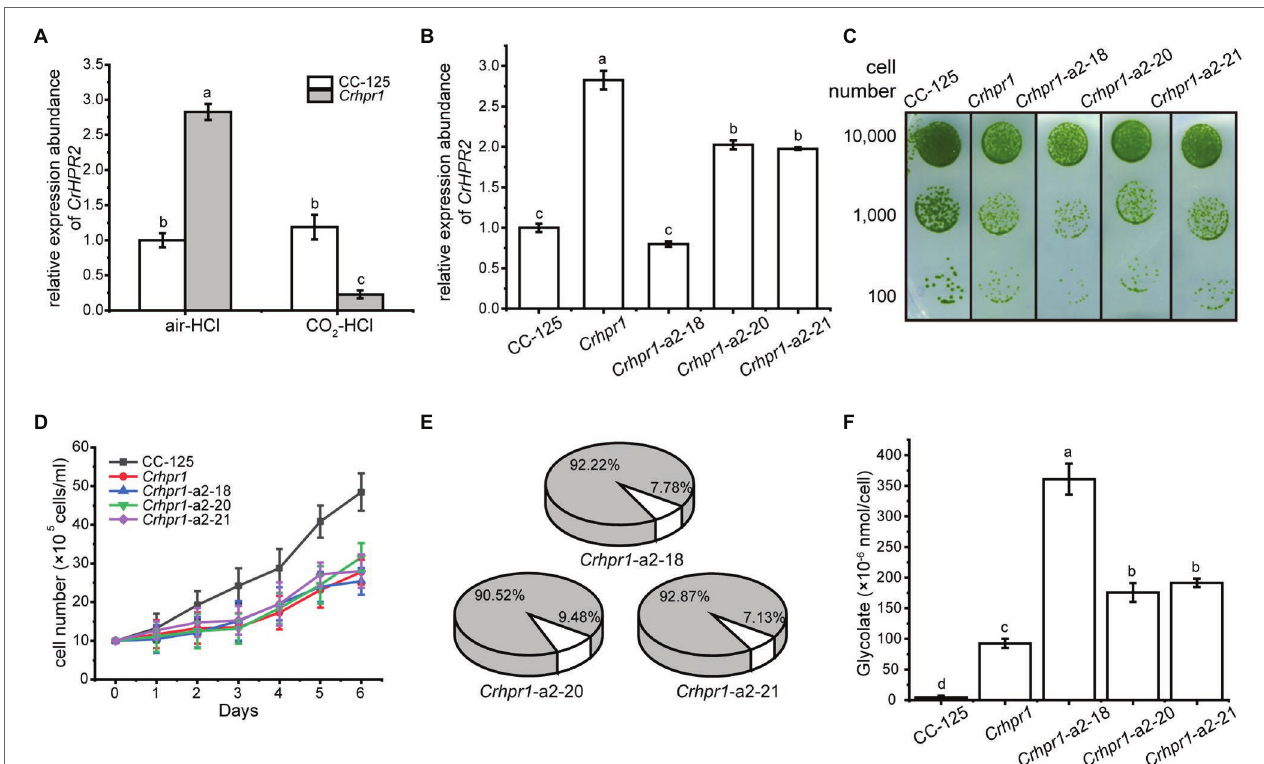
FIGURE 4 | CrHPR2 knockdown strains show photorespiratory defects at Crhpr1 background. (A) Measurement of CrHPR2 transcripts at both WT/CC-125 and Crhpr1 background in air condition. (B) Measurement of CrHPR2 transcripts in Crhpr1 and Crhpr1-a2 strains. (C) Spot tests showing growth of Crhpr1 and Crhpr1-a2 strains. (D) Growth curves of Crhpr1 and Crhpr1-a2 strains in air. (E) The ratio of oxidation and carboxylation reaction of Rubisco in Crhpr1-a2 strains. Carboxylation reaction: white sector. Oxidation reaction: gray sector. (F) Concentration of glycolate detected in the medium of each strain. Mean values ± SD presents data from three measurements. Means denoted by the same letter did not significantly differ at p <